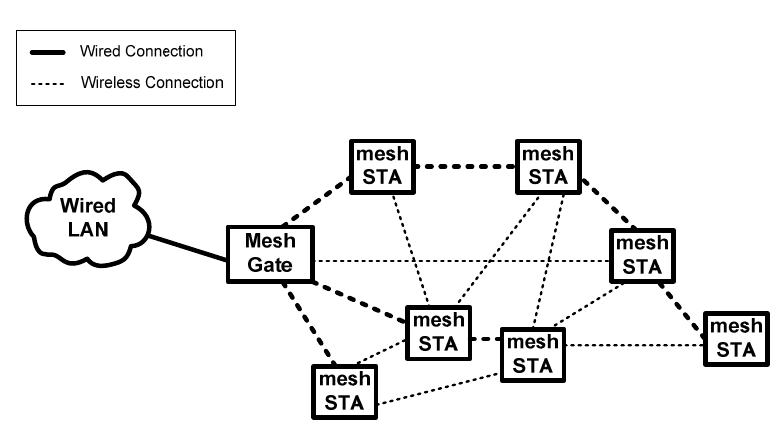
Figure 4. Wireless mesh